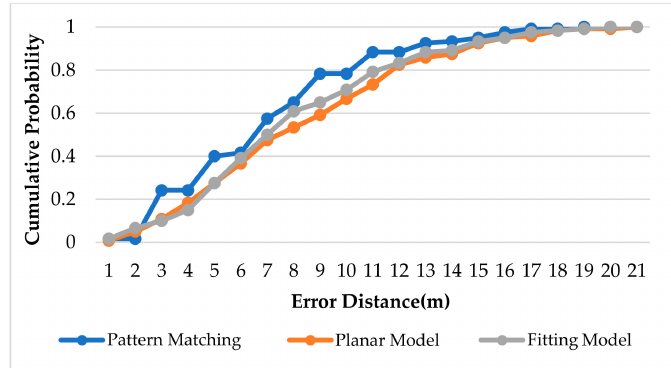
Figure 22. CDF for Area Determination in Basketball Court.